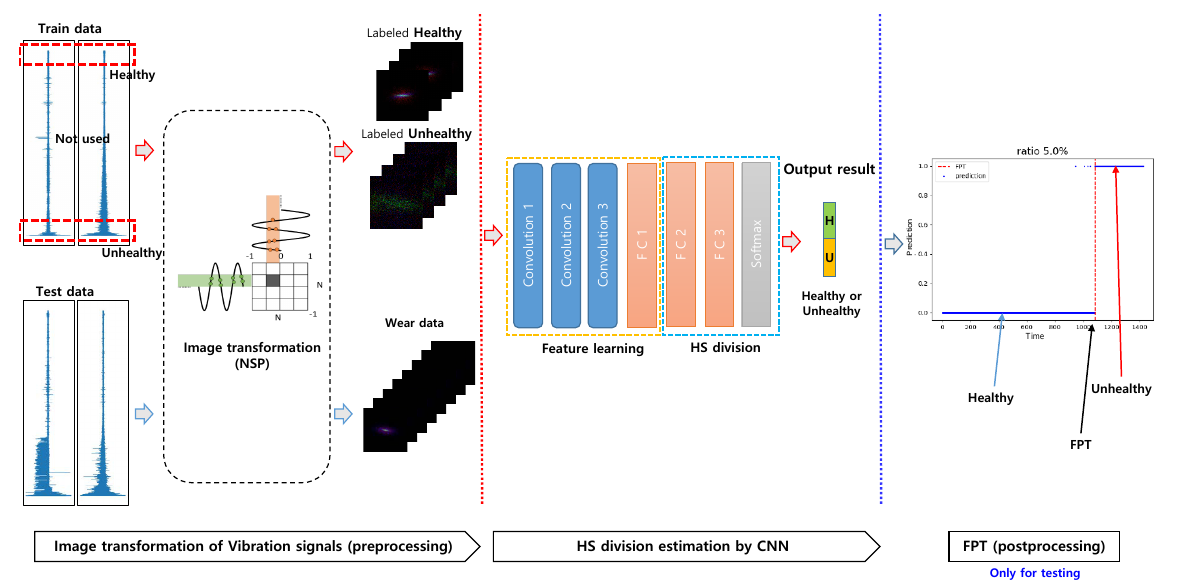
Figure 4. CNN-HS combined with